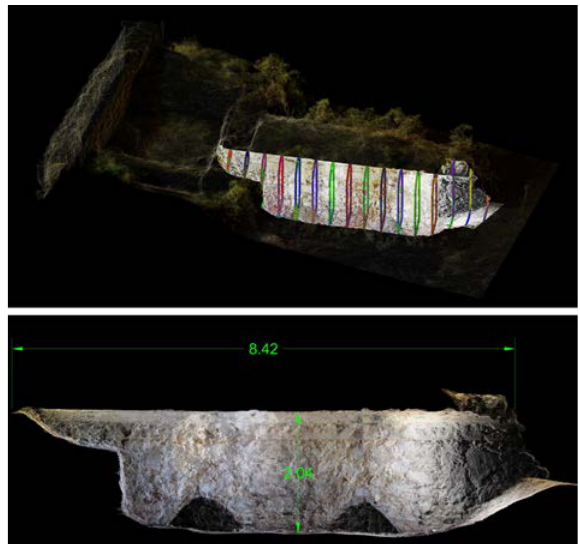
Figure 7. Point cloud renders. Isometric view of subterranean feature of Roman Dam with slices (top); orthographic elevation image of subterranean feature detailing dimension data